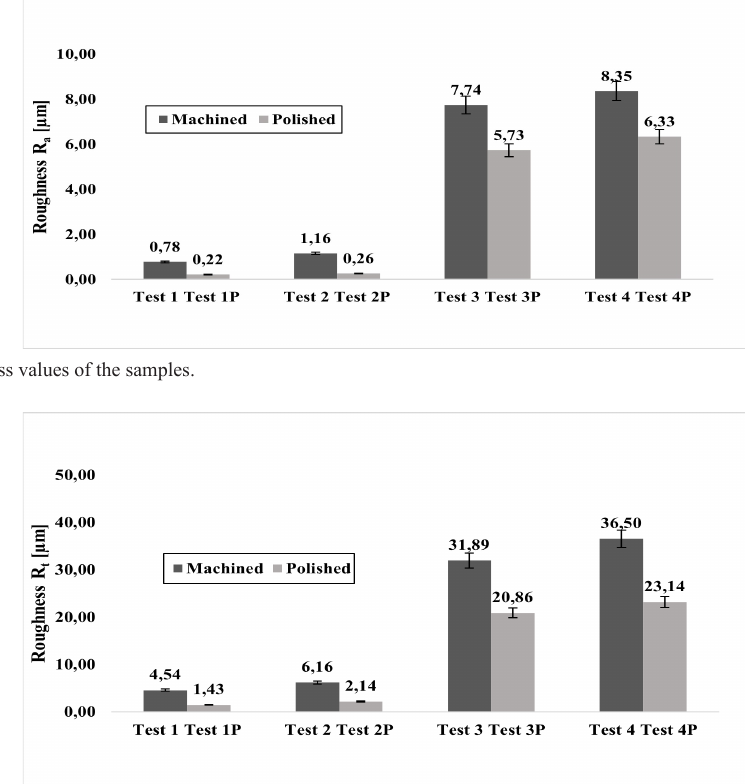
Figure 3. roughness values of the